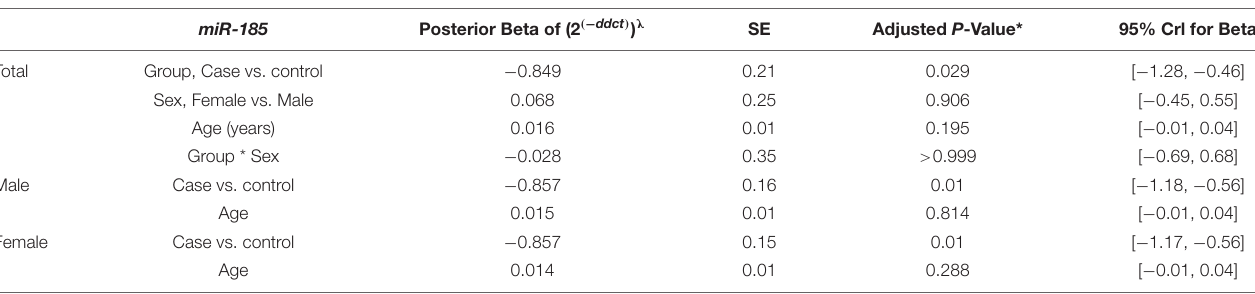
TABLE 4 | Relative levels of miR-185 in AD cases and controls according to the Bayesian quantile regression model.